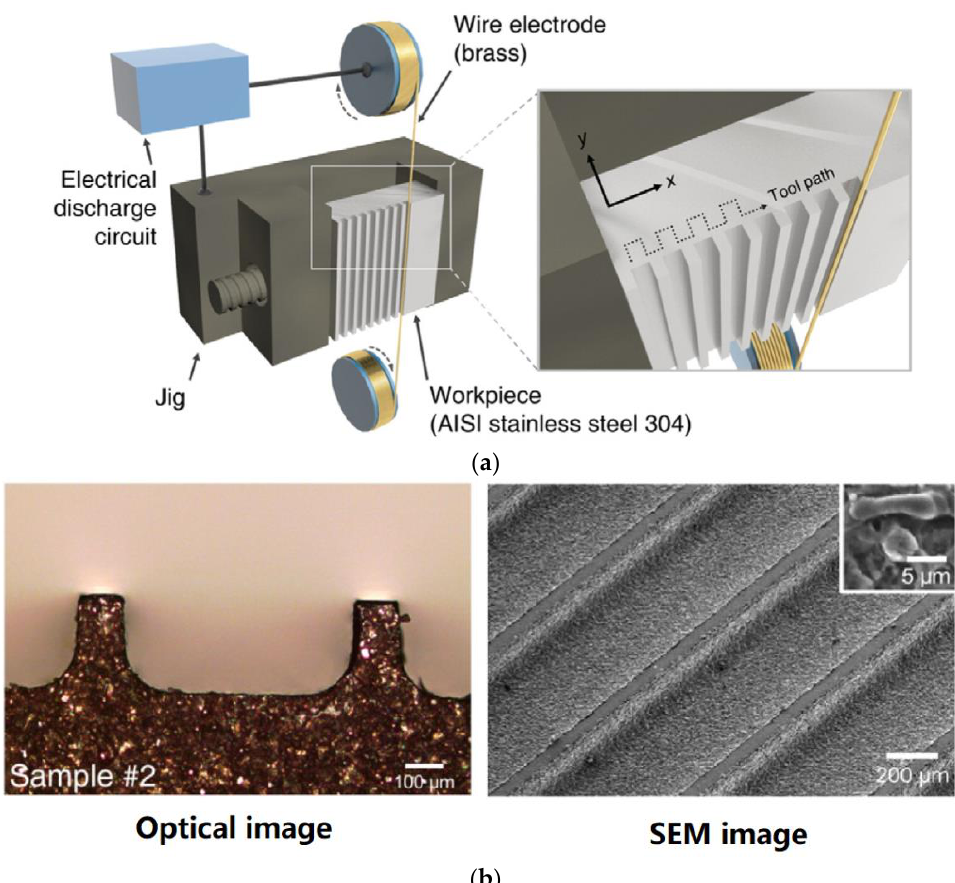
Figure 8. Schematic of the WEDM process and the machined sample [22]; ( a ) schematic illustration of the process; ( b ) optical image and SEM image of the sample.